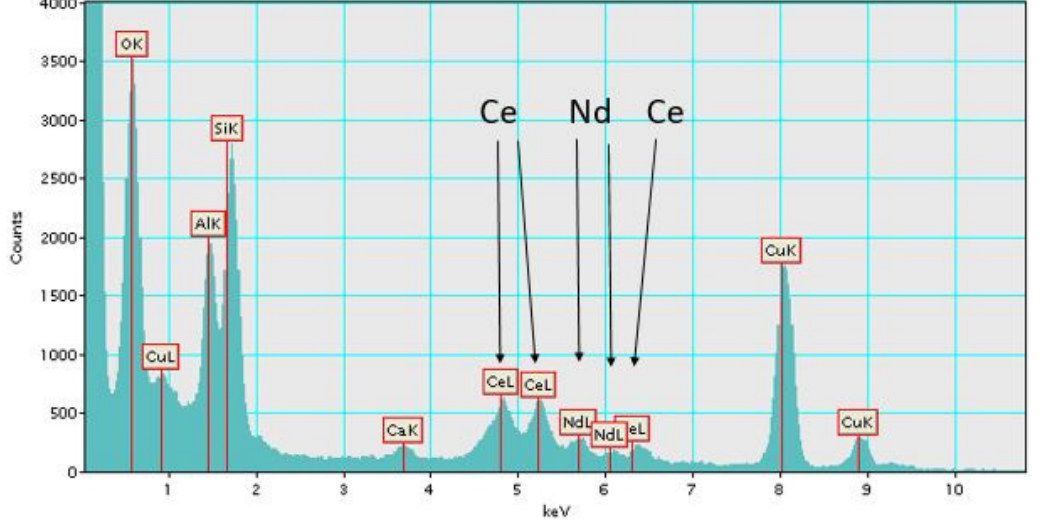
Figure 5. EDS scan of area A showing peaks corresponding to Ce and Nd.